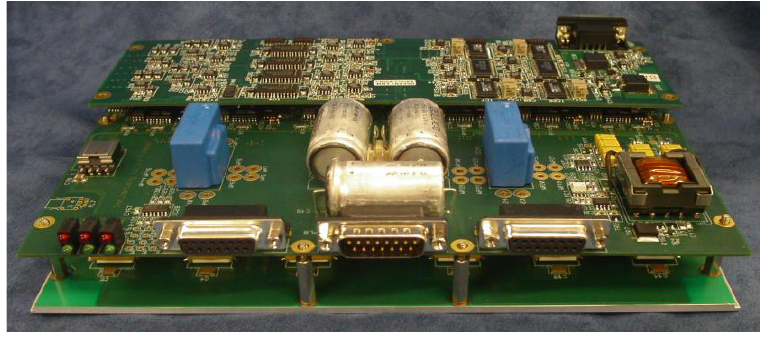
Figure 9. Integrated self-sensing power amplifier